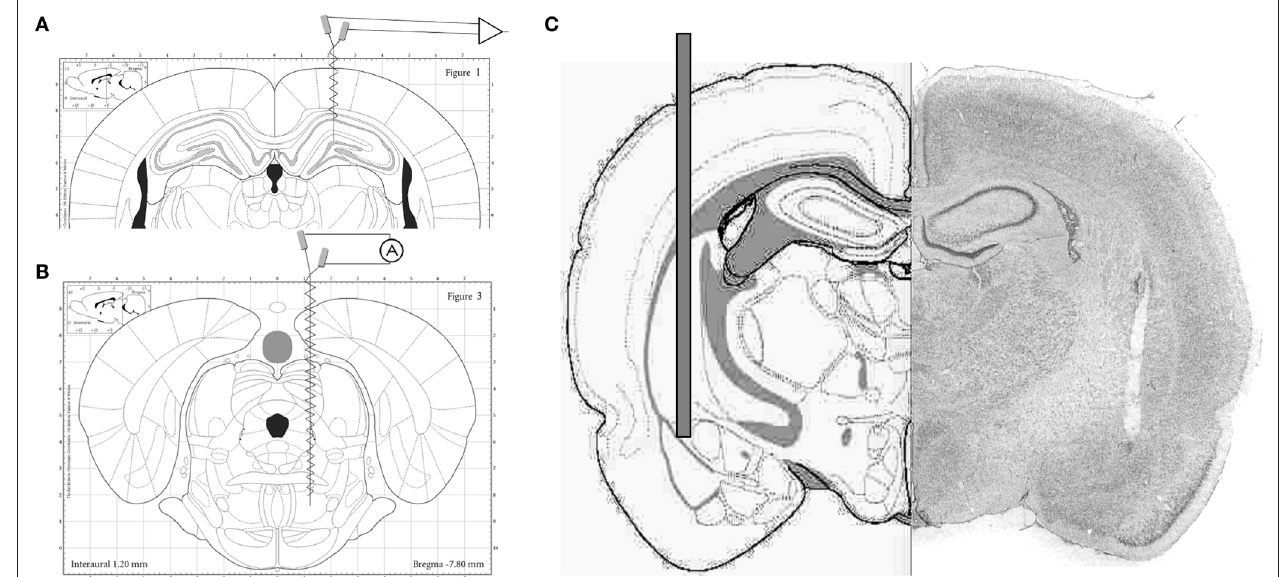
FiguRE 1 | (A) Stereotaxic diagram of electrode placement for hippocampal EEG recordings. (B) Stereotaxic diagram of electrode placement for electrical stimulation of the pontine reticular formation. (C) Stereotaxic diagram (left) and